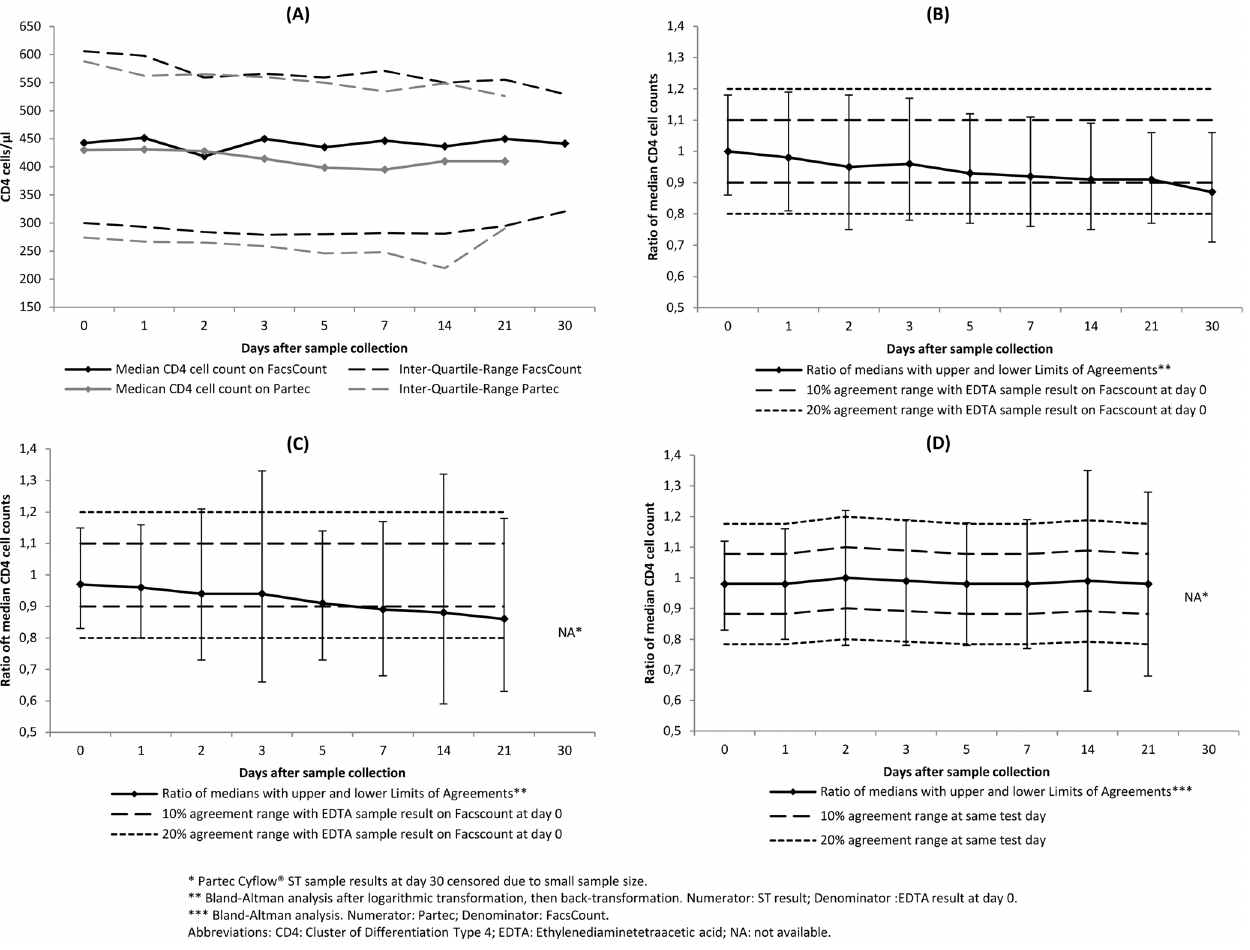
Fig 2. Stability of BD Vacutainer CD4 Stabilization Tube sample results over time. (A) Absolute CD4 cell counts of BD Vacutainer CD4 Stabilization Tube samples on BD FacsCount and Partec Cyflow at days 0 – 30. (B) Agreement of BD Vacutainer CD4 Stabilization Tube sample results on BD FacsCount at days 0 – 30 with EDTA sample results on BD FacsCount at day 0. (C) Agreement of BD Vacutainer CD4 Stabilization Tube sample results on Partec Cyflow at days 0 – 30 with EDTA sample results on BD FacsCount at day 0. (D) Agreement of BD Vacutainer CD4 Stabilization Tube sample results on Partec Cyflow at days 0 – 30 with same day results of BD Vacutainer CD4 Stabilization Tube sample results on BD